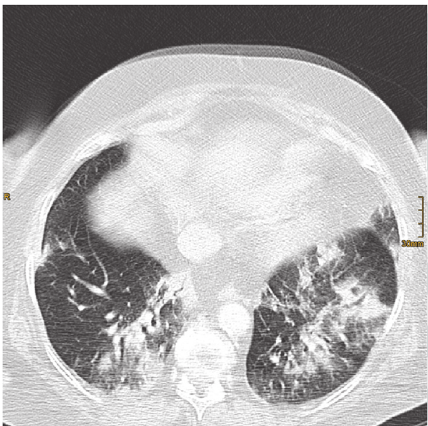
Figure 1: Illustrating diffuse bilateral infiltrates of the